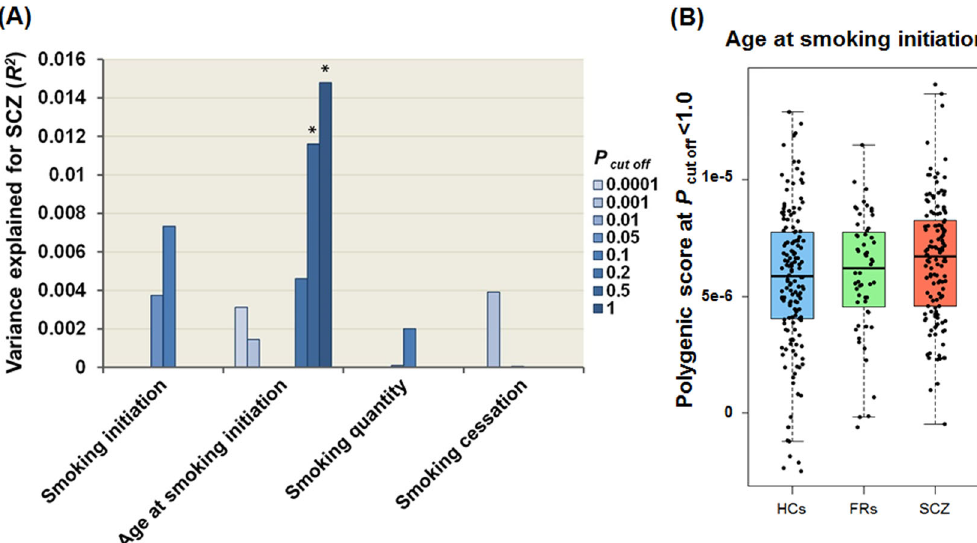
Fig. 2 Effects of PRSs for European-based smoking-related intermediate phenotypes on the risk of SCZ in a Japanese population. Effects of PRSs for four European-based smoking-related intermediate phenotypes on the risk of SCZ (HCs, FRs, and patients with SCZ) ( a ). * p < 0.05. Differences in PRSs based on European-based age at smoking initiation among HCs, FRs, and patients with SCZ ( b ). HC healthy control; FR fi rst-degree relative; SCZ schizophrenia.